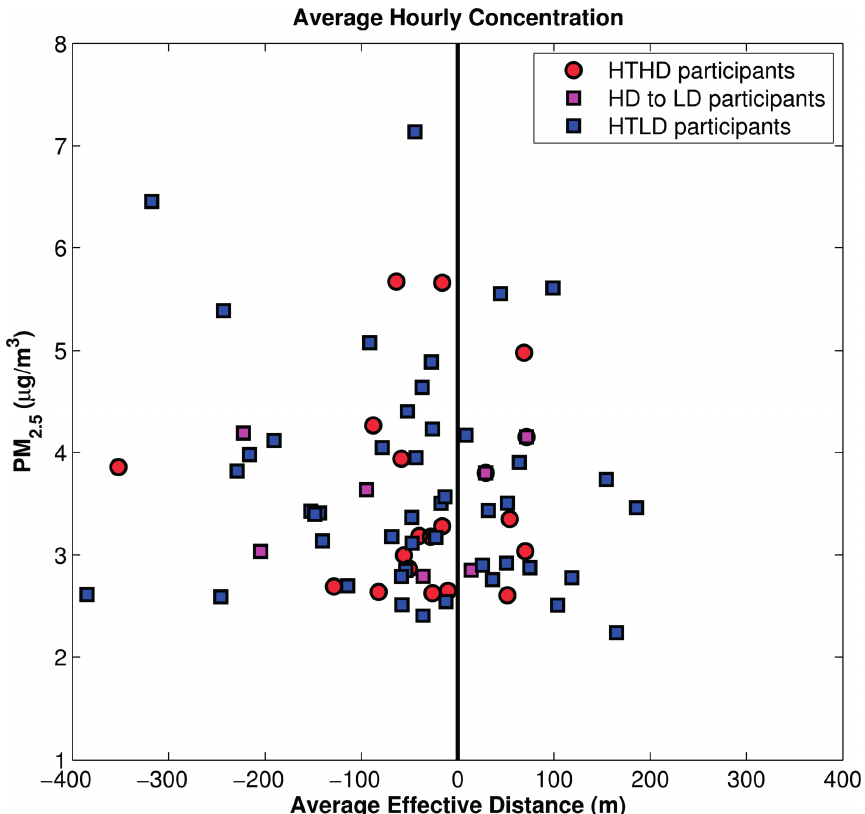
Figure 15. Average hourly concentration for PM participants, participants switched from HD to LD, and HTLD